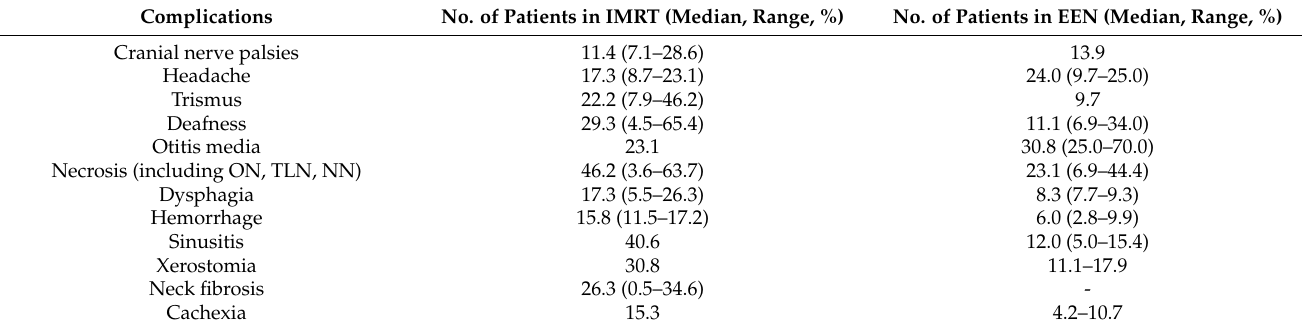
Table 3. Complications of the two main treatment modalities for recurrent NPC.